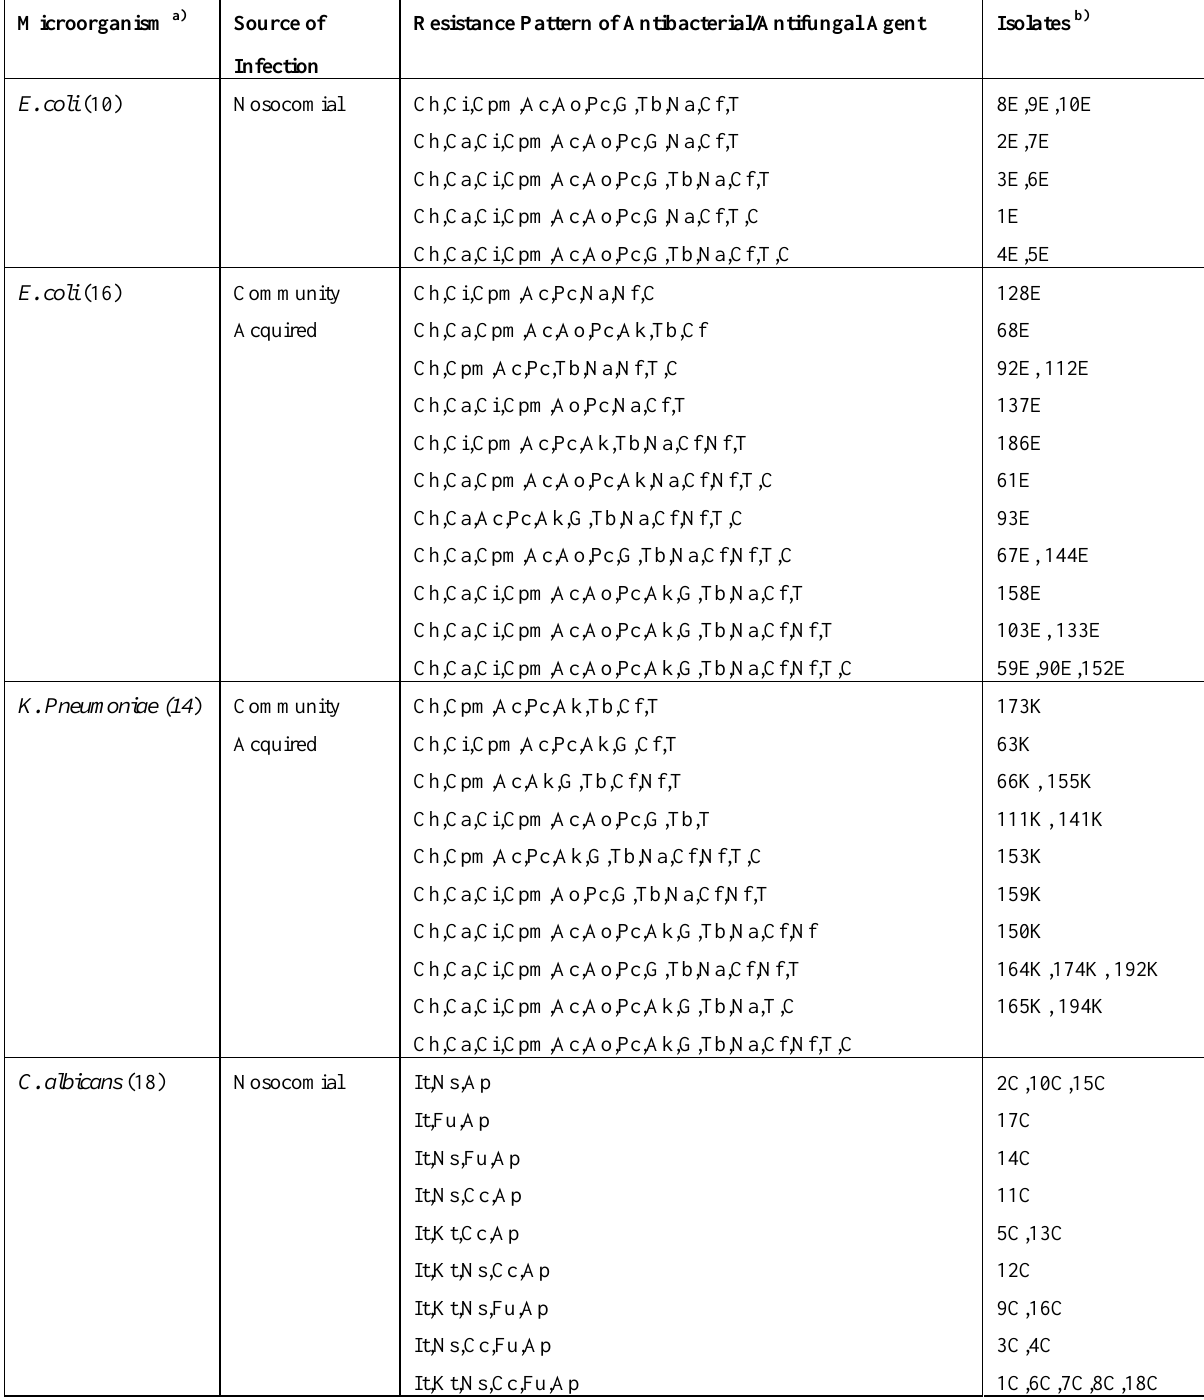
Table 3. Resistance Profile of Multi-Drug Resistant Isolates of Nosocomial and Community Acquired